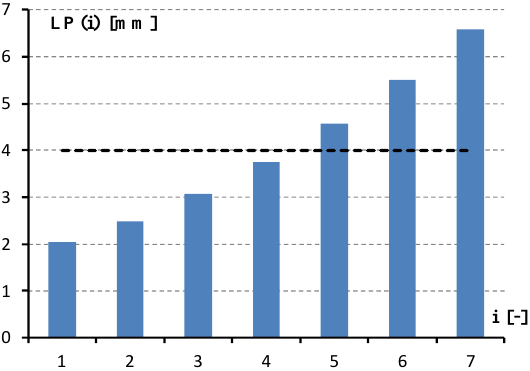
Figure 9. Resultant distribution of the staggered seal pitch lengths; discontinuous line marks the constant length of the pitch of the initial geometry.